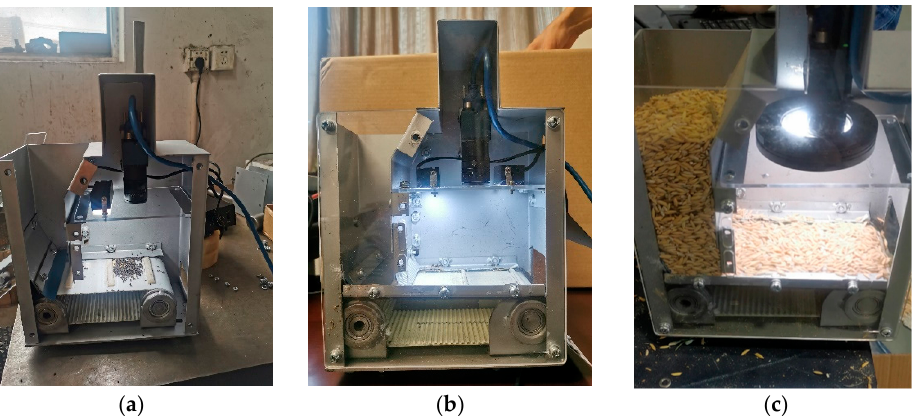
Figure 3. Different light irradiations of sampling device: ( a ) single-sided-strip LED, ( b ) double-sided- strip LED, ( c ) central-ring